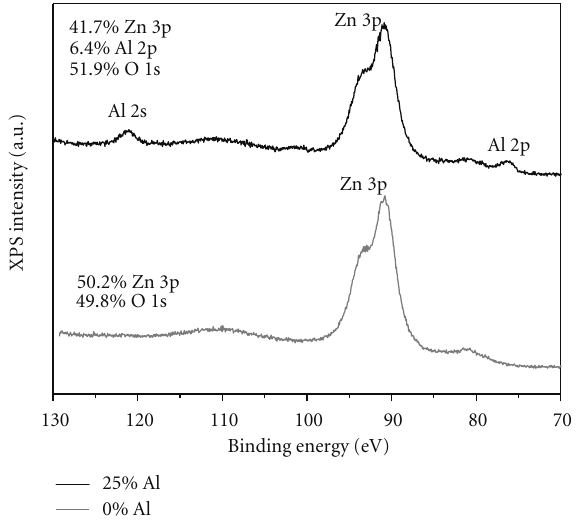
Figure 3: XPS spectra of the pure and Al doped ZnO films. The presence of aluminum decreased the concentration of Zn, indicating that Al is a substitutional